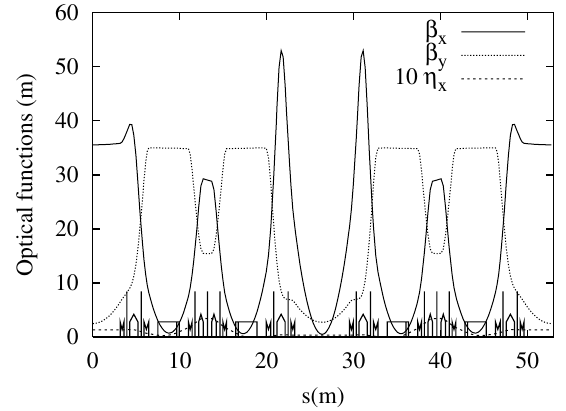
FIG. 9. Lattice functions for one of the 12 ESRF superperiods composed of two TBA